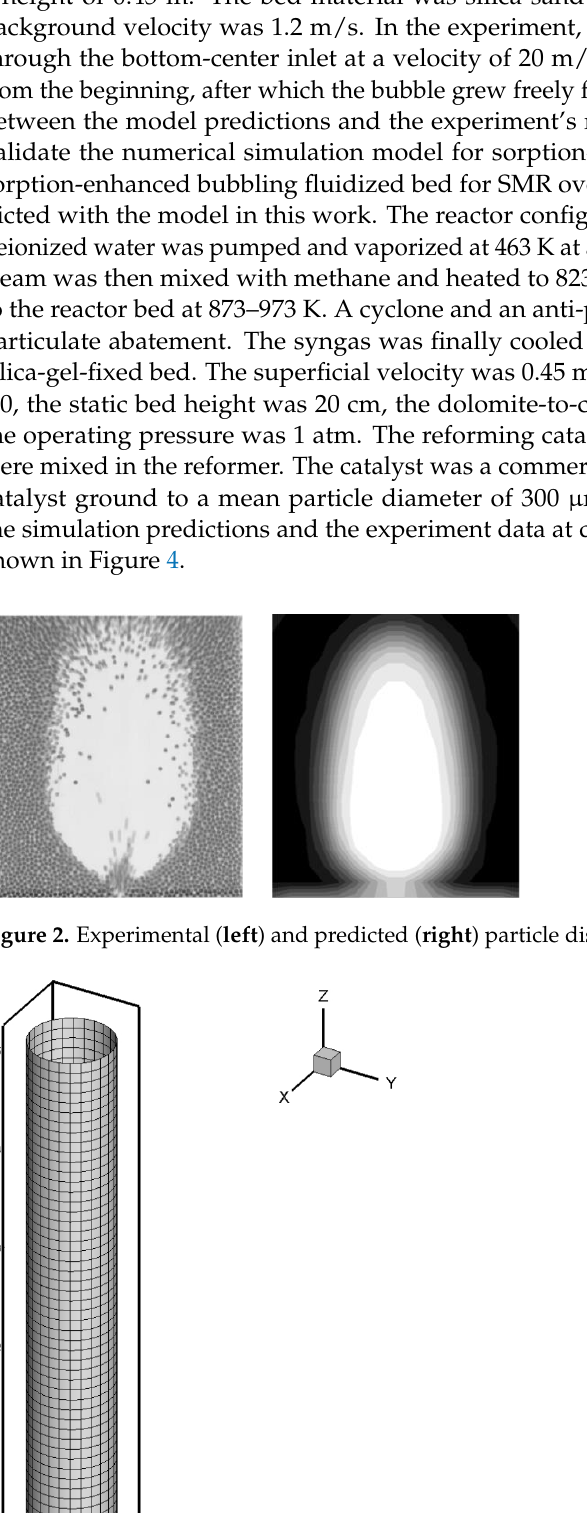
4 of 13 Figure 1. The dual fluidized bed reactor ’s configuration. ( a ) Technical flow sheet of the dual fluid- ized bed reactor. ( b ) Structure of the dual fluidized bed reactor. ( c ) Mesh of the computational zone.